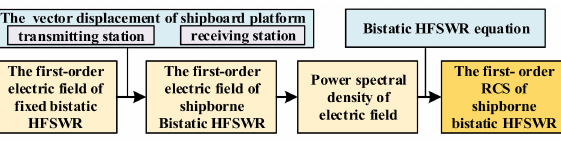
Figure 2. Derivation process of the first order